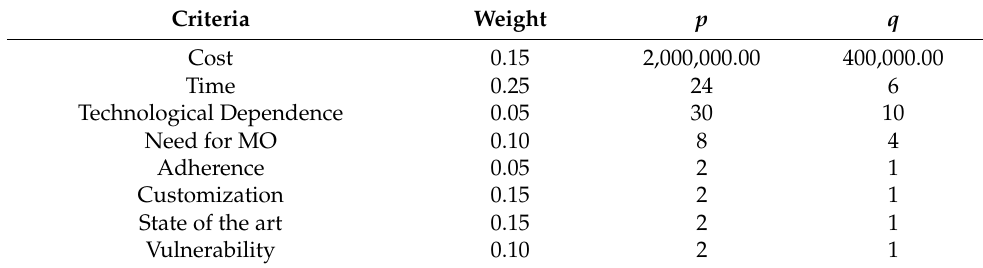
Table 2. Criteria weights and thresholds.